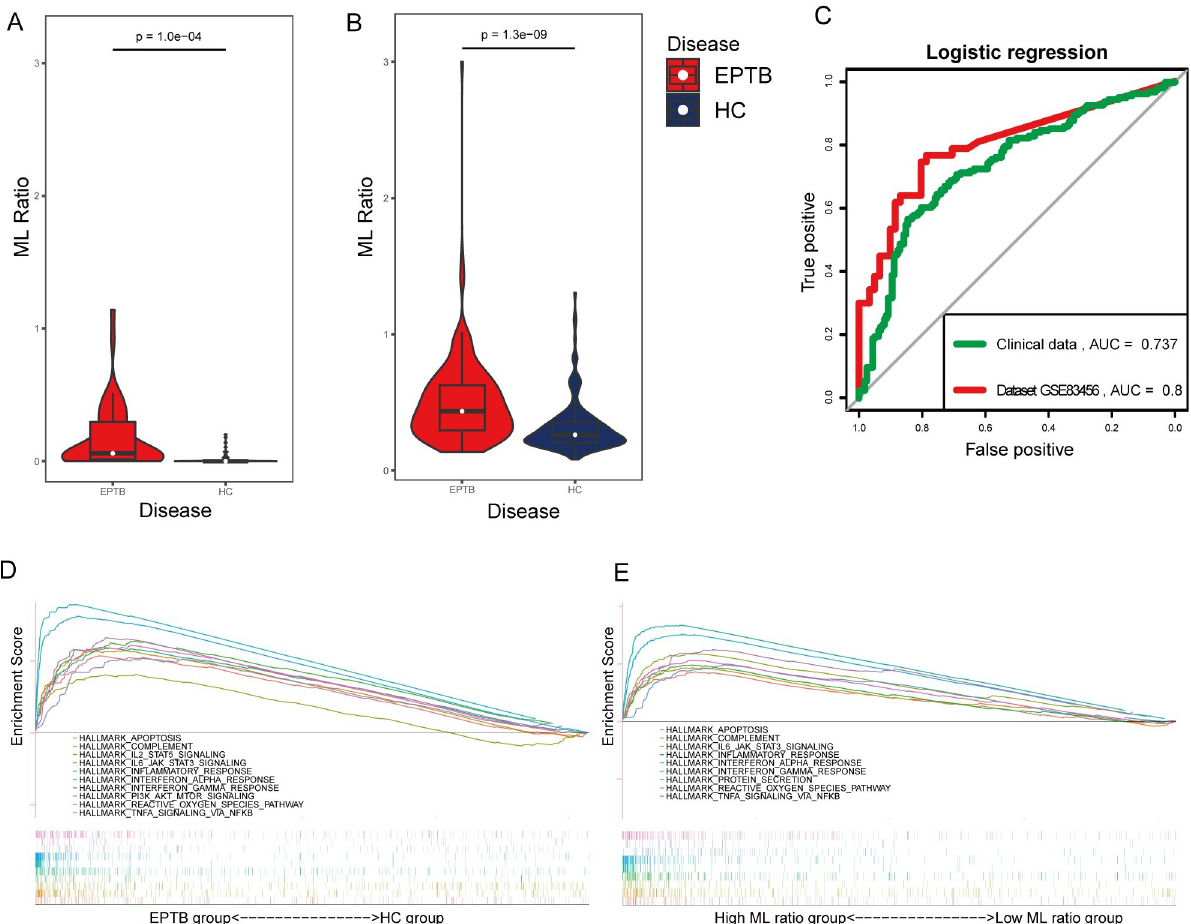
Fig 2. T test of ML ratio between EPTB and healthy controls and GSEA analysis. (A) Violin plot showed the ML ratio between EPTB and healthy controls in dataset GSE83456. (B) Violin plot showed the ML ratio between EPTB and healthy controls in clinical data. (C) AUCs of the nomogram based on ML ratio in GSE83456 and clinical data. (D) The enriched gene sets in HALLMARK collection by the EPTB samples. (E) The enriched gene sets in HALLMARK collection by the high ML ratio samples.